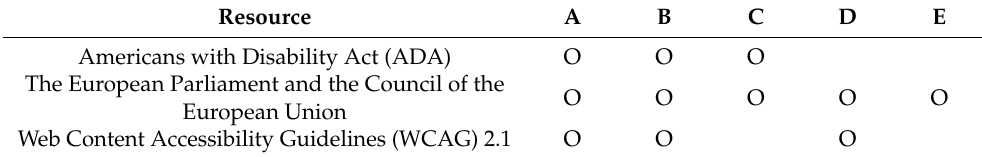
Table 2. Accessibility standards and